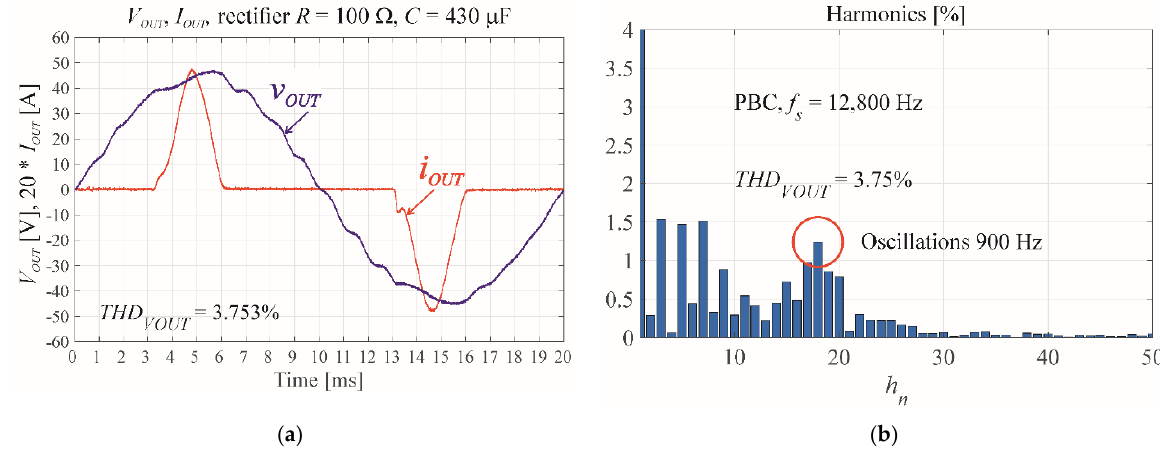
Figure 11. ( a ) The output voltage and current; ( b ) The harmonics analysis of the output voltage for the PBC with exper- imentally adjusted border gains ( R i = 2, K v = 0.2, R i ’ = 1.83, K v ’ = 0.183) for f s = 12,800 Hz (RC load: R = 100 Ω , C = 430 μ F); ( a ) and ( b ) Harmonics analysis of the output voltage.